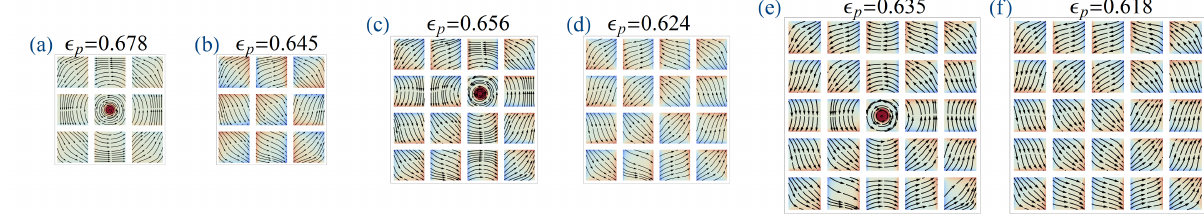
Figure 4. Macro-vortex states for ordered assemblies of nanoplatelets with various square array sizes; 3 × 3 ((a) and (b)), 4 × 4 ((c) and (d)) and 5 × 5 ((e) and (f)). The geometrical parameters are: L = 90 nm, L z = 12 nm and δ = 15 nm. The macro-vortex state has either a vortex core inside a platelet ((a), (c) and (e) configurations) or no vortex core ((b), (d) and (f) configurations). For each configuration, the reduced magnetic energy (cid:15) p is provided. The color code and the arrows meaning are the same as in Fig. 2.